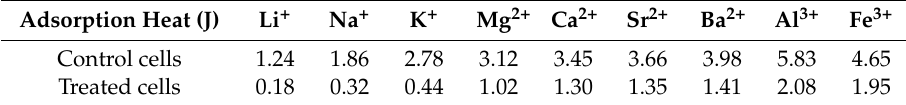
Table 2. Adsorption heat of cations on M. aeruginosa cells after the addition of